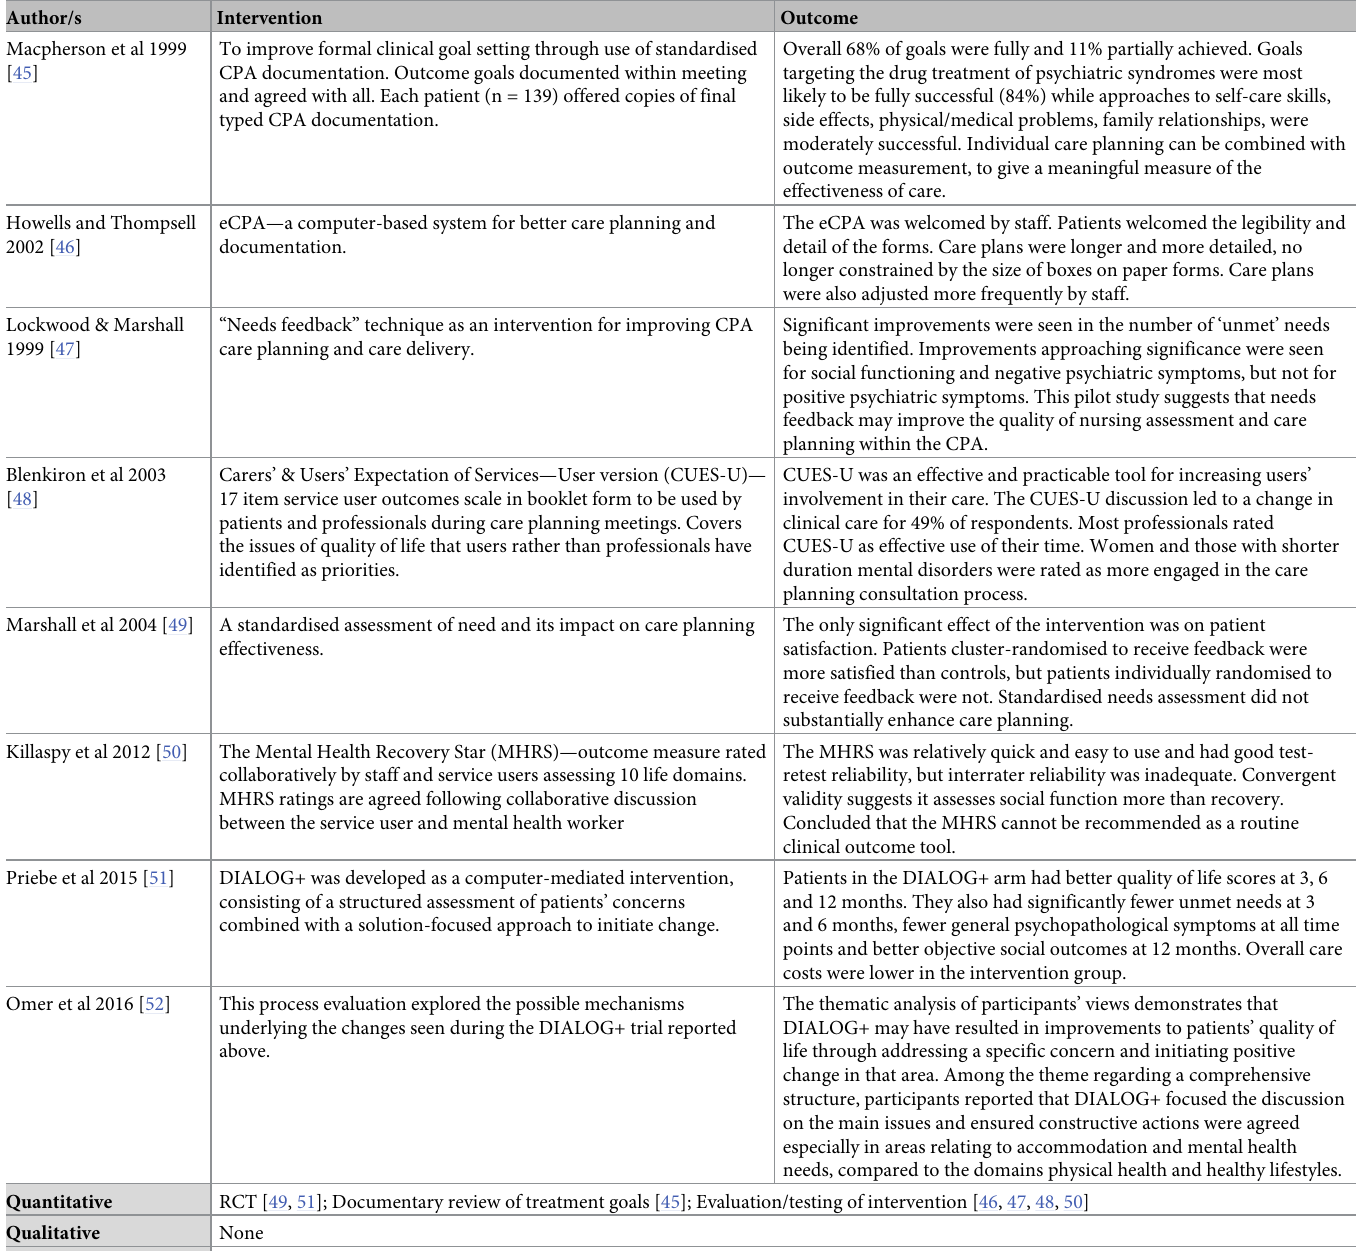
Table 3. Tradition 2: Interventions to improve care planning and coordination in the